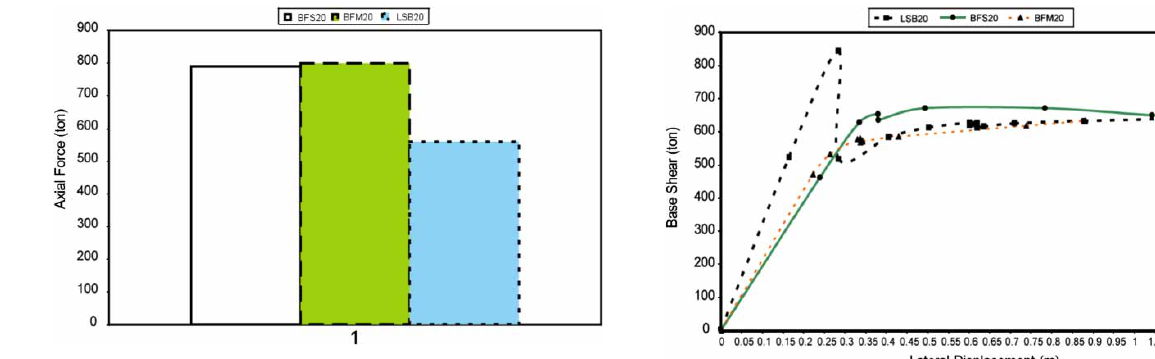
Fig. 25. Capacity curves of the different